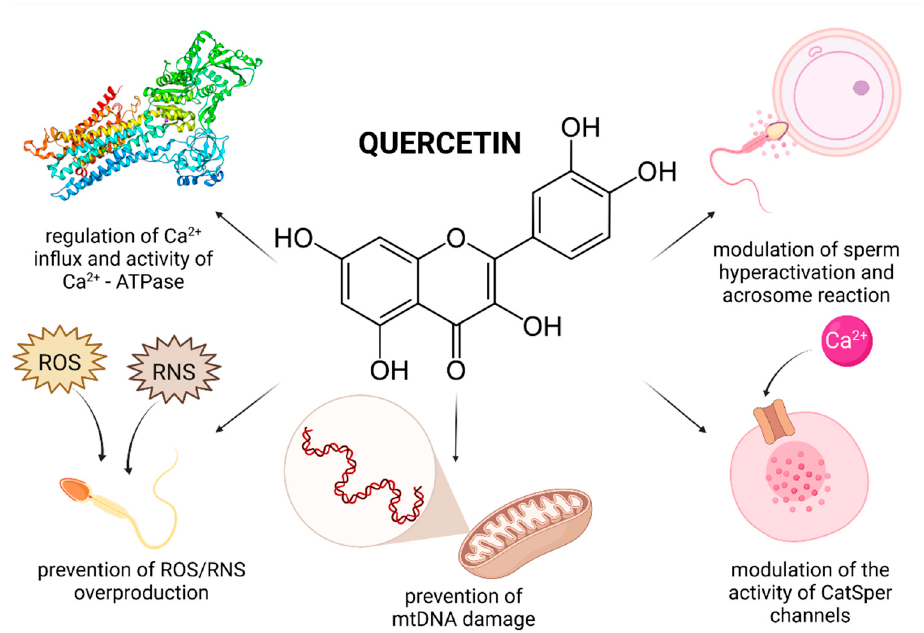
Figure 2. Most frequently reported beneficial effects of quercetin on spermatogenesis, sperm struc- tural integrity and functional activity.